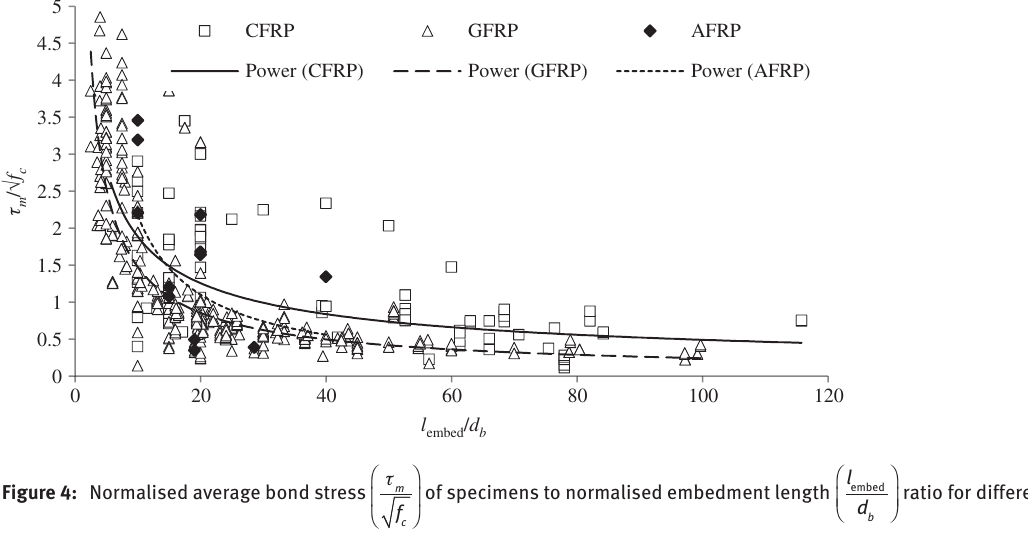
Figure 4: Normalised average bond stress